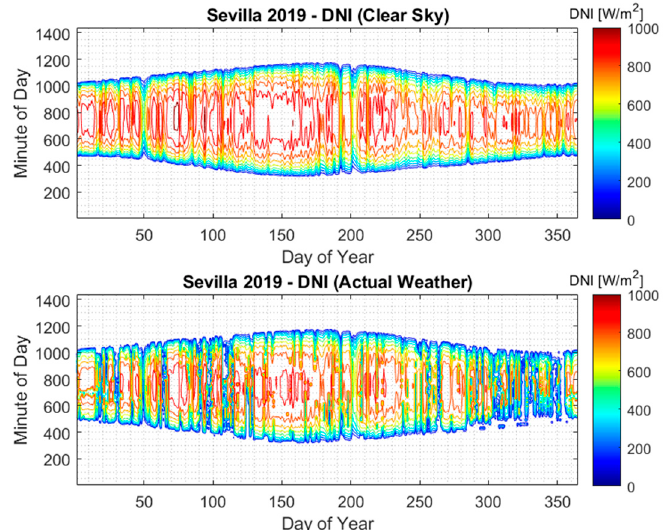
Figure A2. Heat map of yearly DNI distribution for Clear Sky and Actual Weather in Seville, Spain (Year: 2019).